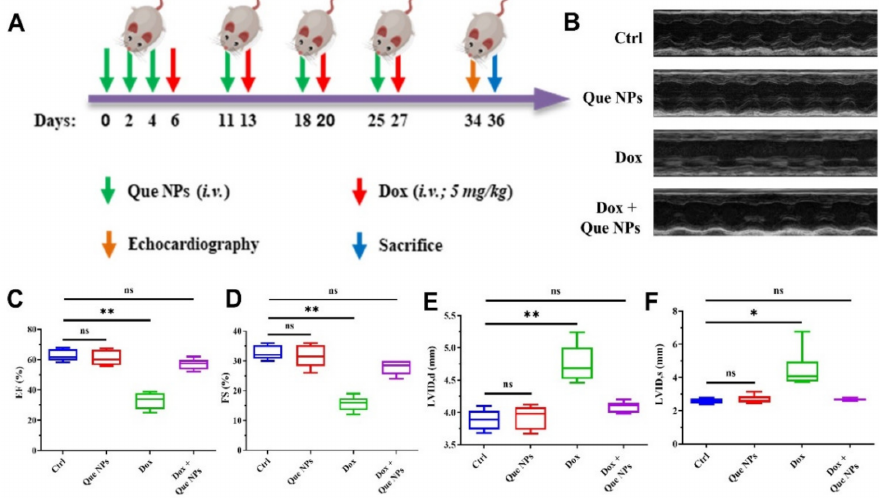
Figure 4. ( A ) Schematic description of the mouse model; ( B ) representative echocardiographic images; and ( C – F ) statistical analysis of the echocardiographic data. *, p < 0.05; **, p < 0.01; ns, no significance.